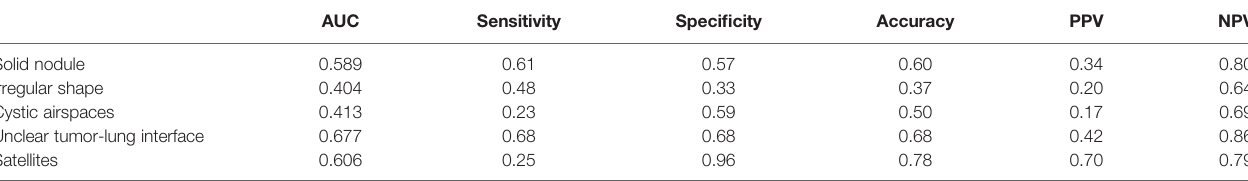
TABLE 2 | Diagnostic performances of traditional radiologic features of STAS+ lung